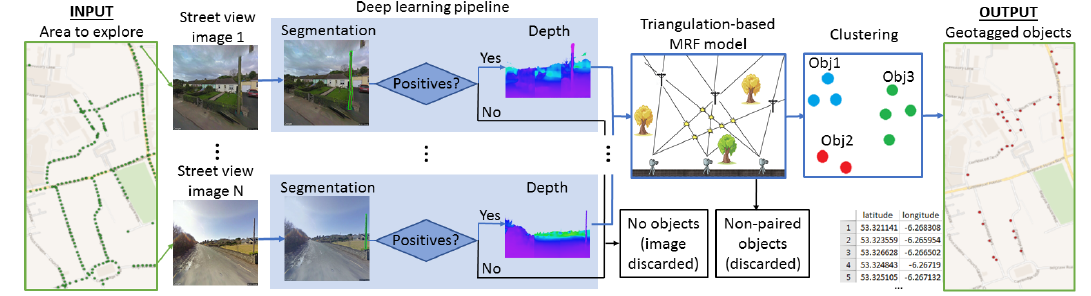
Figure 1. Proposed geotagging pipeline: from an area of interest with street view images (green dots) to geotagged objects (red